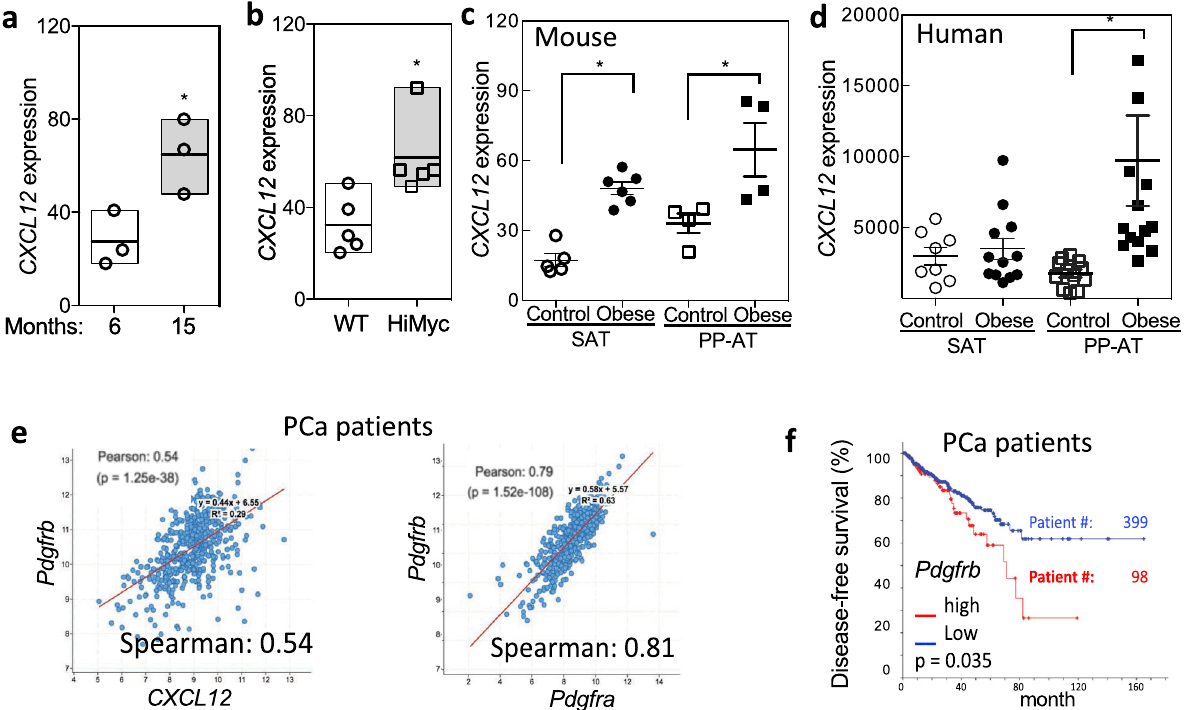
Fig. 5 CXCL12 link with age, obesity, and cancer in mice and humans. a – c RT-PCR analysis of CXCL12 mRNA expression normalized to mGapdh . a Relative CXCL12 mRNA expression in anterior prostate of 6-month- and 15-month-old HiMyc chow-fed mice; N = 3; * P < 0.05 compared to WT (Student ’ s t test). b Relative CXCL12 mRNA expression in anterior prostate of 6-month-old WT and HiMyc chow-fed mice; N = 5; * P < 0.05 (Student ’ s t test). c Relative CXCL12 mRNA expression in SAT and periprostatic (PP-AT) adipose tissue of C57BL/6 mice raised for 5 months on chow (control) or HFD (obese); N = 4 – 6; * P < 0.05 (Student ’ s t test). d Relative CXCL12 mRNA expression normalized to hGapdh in stromal cells of SAT and periprostatic AT samples from control (BMI < 30; N = 8 – 11) or obese (BMI > 30; N = 12 – 16) PCa patients. * P < 0.05 (Student ’ s t test). e Analysis of mRNA expression correlation between PDGFRb and CXCL12 , as well as between Pdgfrb and Pdgfra , in 498 primary prostate tumors from the TCGA cohort. P and r values were calculated using Pearson correlation test. f Kaplan – Meier curves, based on data